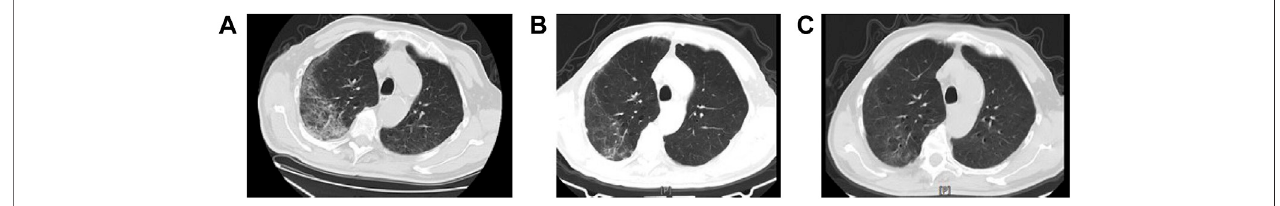
FIGURE 1 | Chest computed tomographic (CT) images of a 66-year-old COVID-19 patient before and after QFPDD. Case 6: A 66-year-old male with severe COVID-19. Panel 2- (A) : In both lungs, transmissibility was reduced, and ground-glass opacity and mesh shadows were observed mostly under the pleura and with